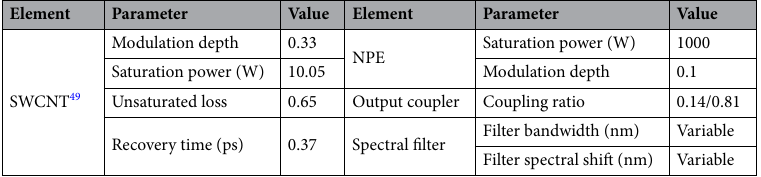
Table 2. Parameters of passive cavity